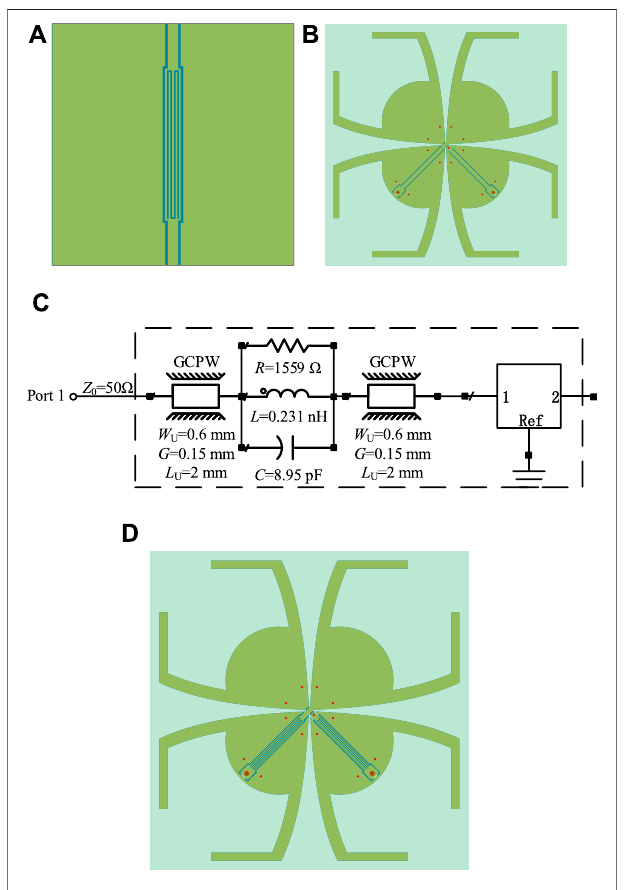
FIGURE 8 | (A) Proposed DMS resonator, (B) one-order band-notched antenna, and (C) the equivalent circuit when cascading these two parts. (D) Proposedband-notched antenna withthe DMS resonator embedded intothe GCPW feeding line of the one-order band-notched antenna.